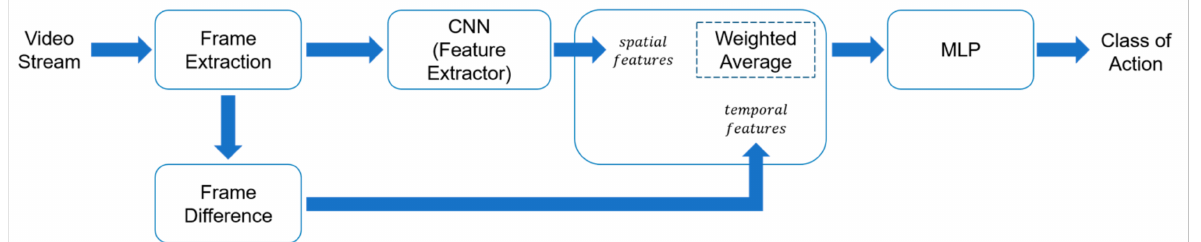
Figure 2. Block diagram of the proposed weighted mean-based human action recognition (HAR)